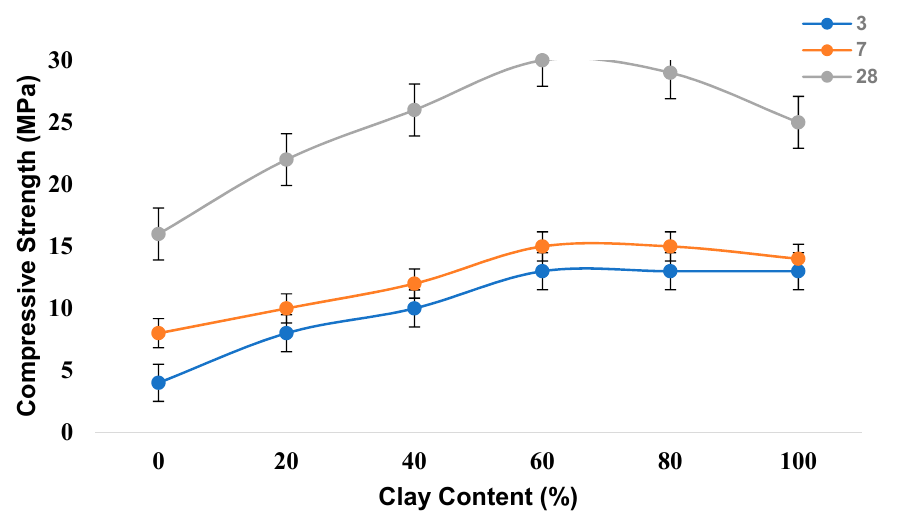
Figure 6. Effect of clay content on the compressive strength of geopolymer.